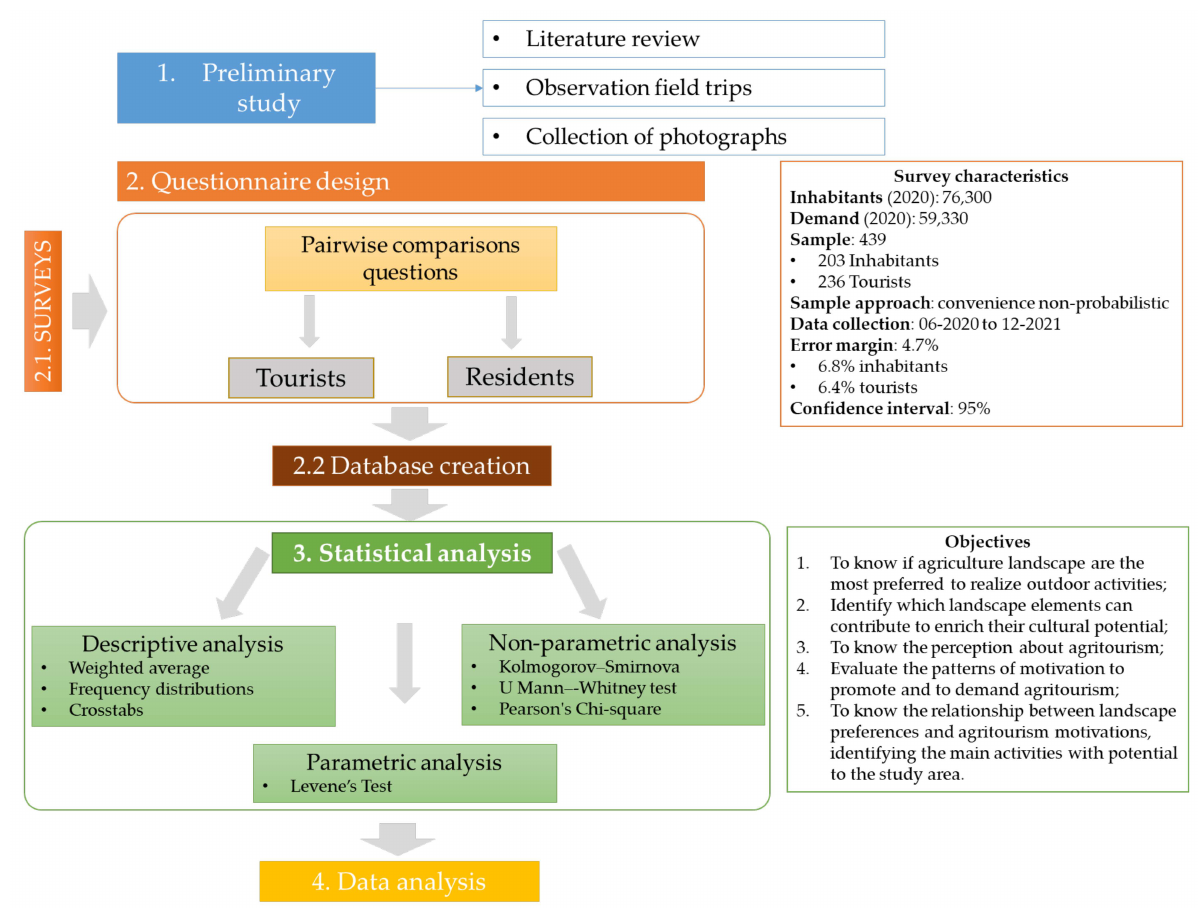
Figure 3. Methodological